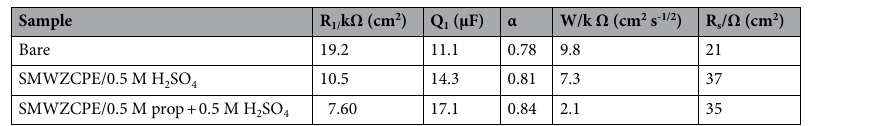
Table 2. Electrochemical impedance parameters .